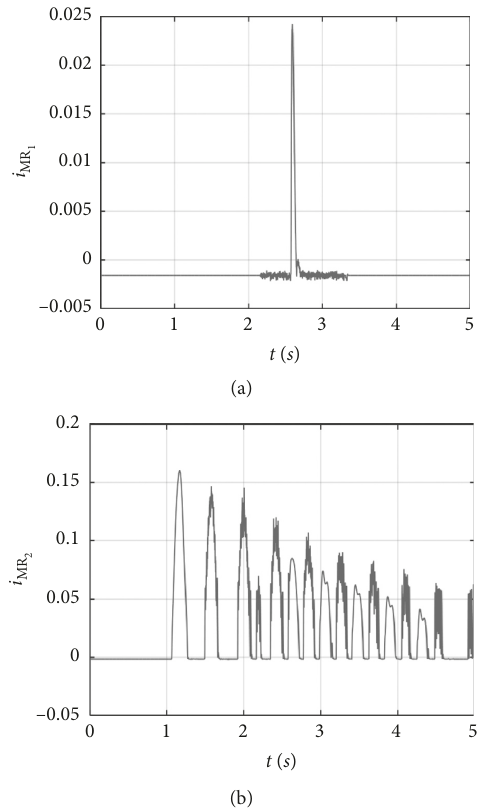
Figure 18: Estimative current to control MR brake torque in (a) joint one and (b) joint